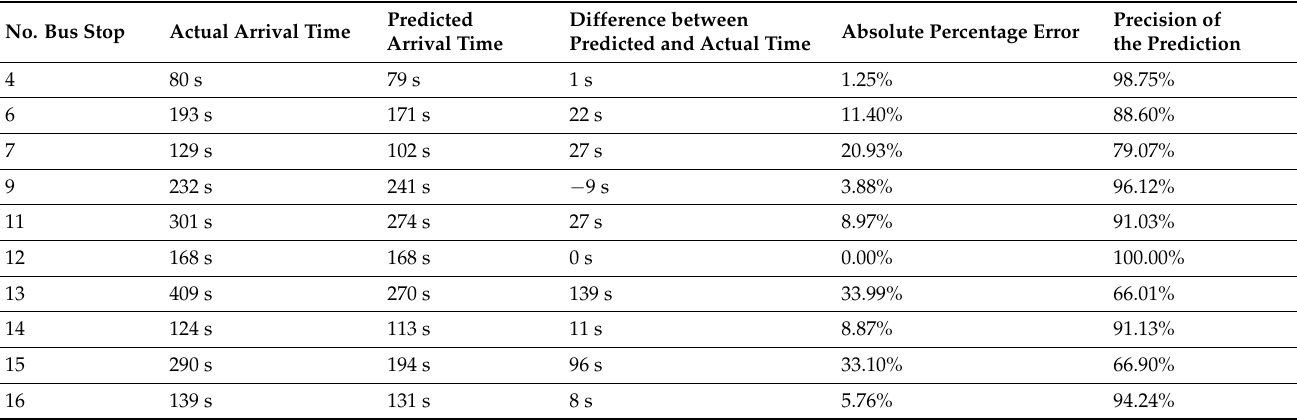
Table 1. Results obtained for Trip 1 (Guacamayas–University Journey) MAE = ± 34 s, MAPE = 12.8% Precision = 87.2%.